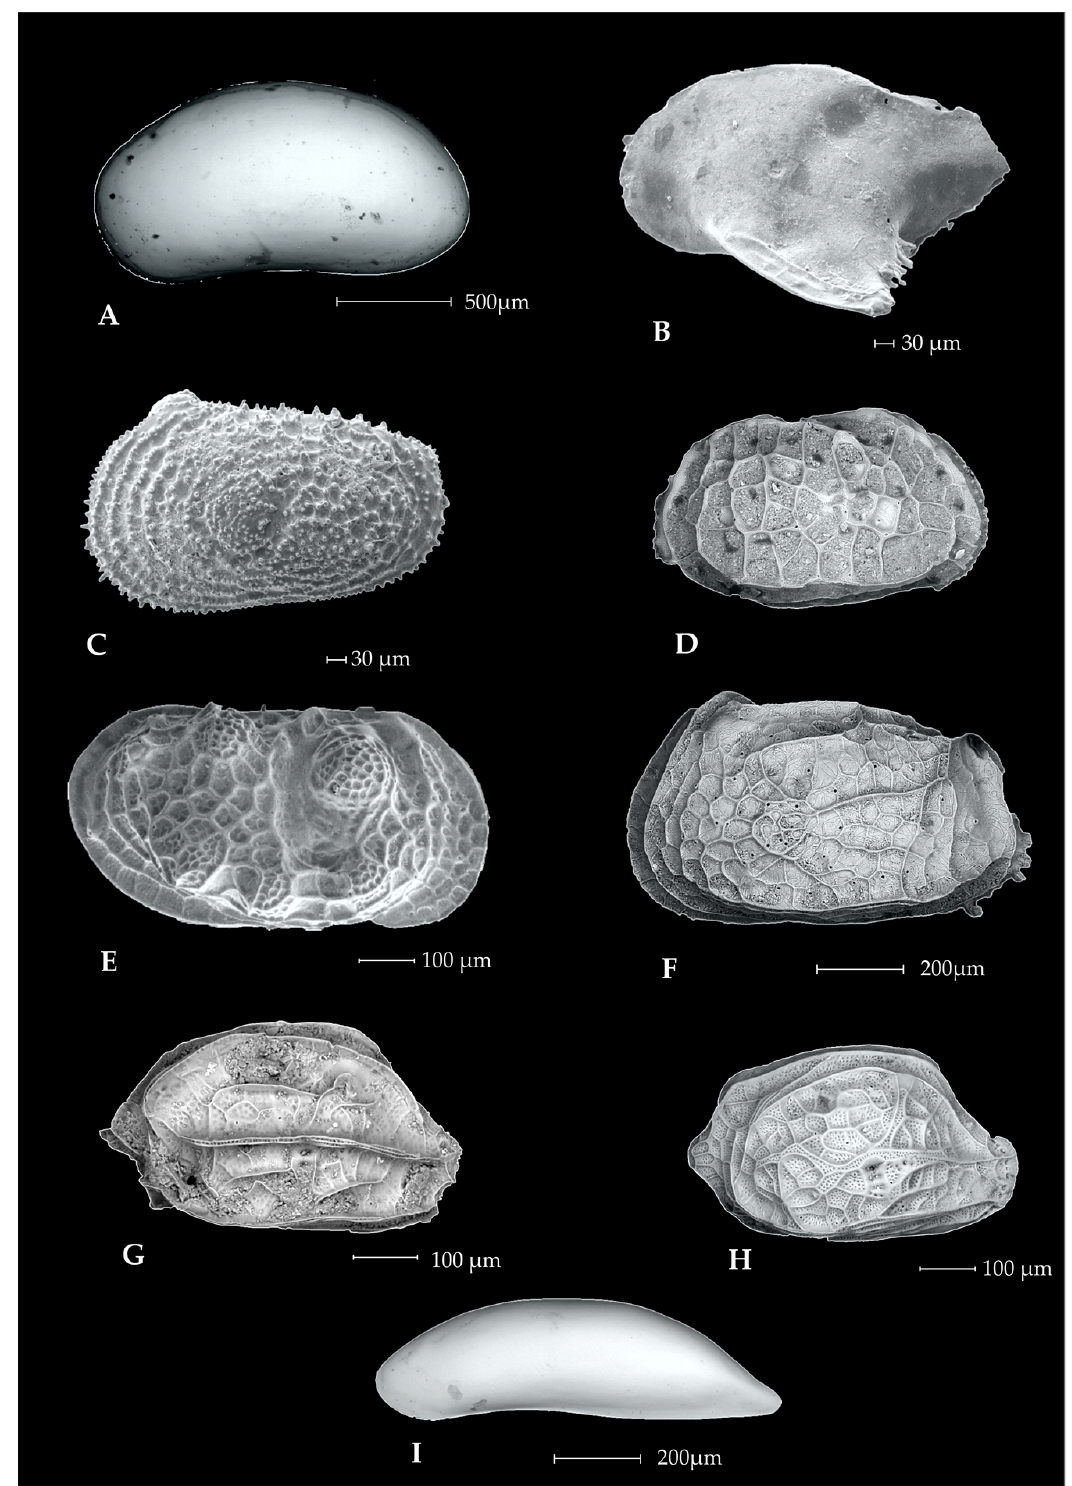
Figure A2. (EA assemblage)—( A )— Argilloecia sp., lateral exterior view, left valve. ( B )— Cytheropteron sp., lateral exterior view, left valve. ( C )— Echinocythereis sp., lateral exterior view, left valve. ( D )— Myrena meridionalis , lateral exterior view, right valve. ( E )— Nodoconcha minuta , lateral exterior view, right valve. ( F )— Patagonacythere longiducta , lateral exterior view, left valve. ( G )— Hemicy- therura anomala , lateral exterior view, right valve. ( H )— Hemicytherura irregularis , lateral exterior view, right valve. ( I )— Xiphichilus gracilis , lateral exterior view, left valve.